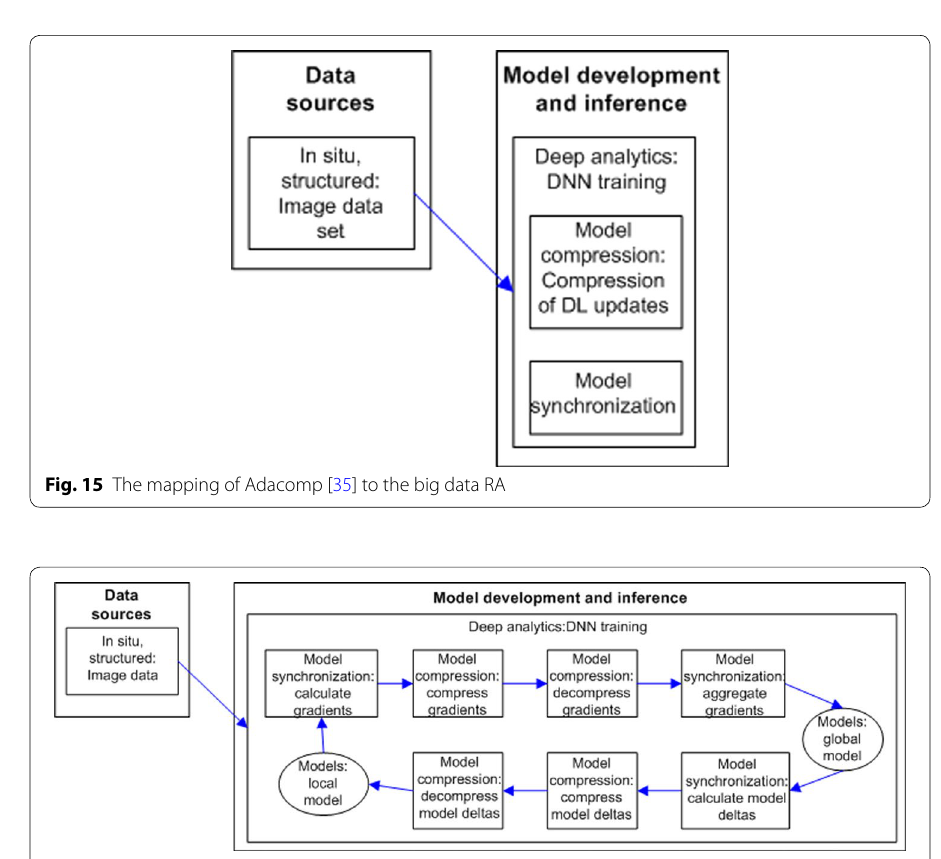
Fig. 16 The mapping of 3LC [36] to the big data